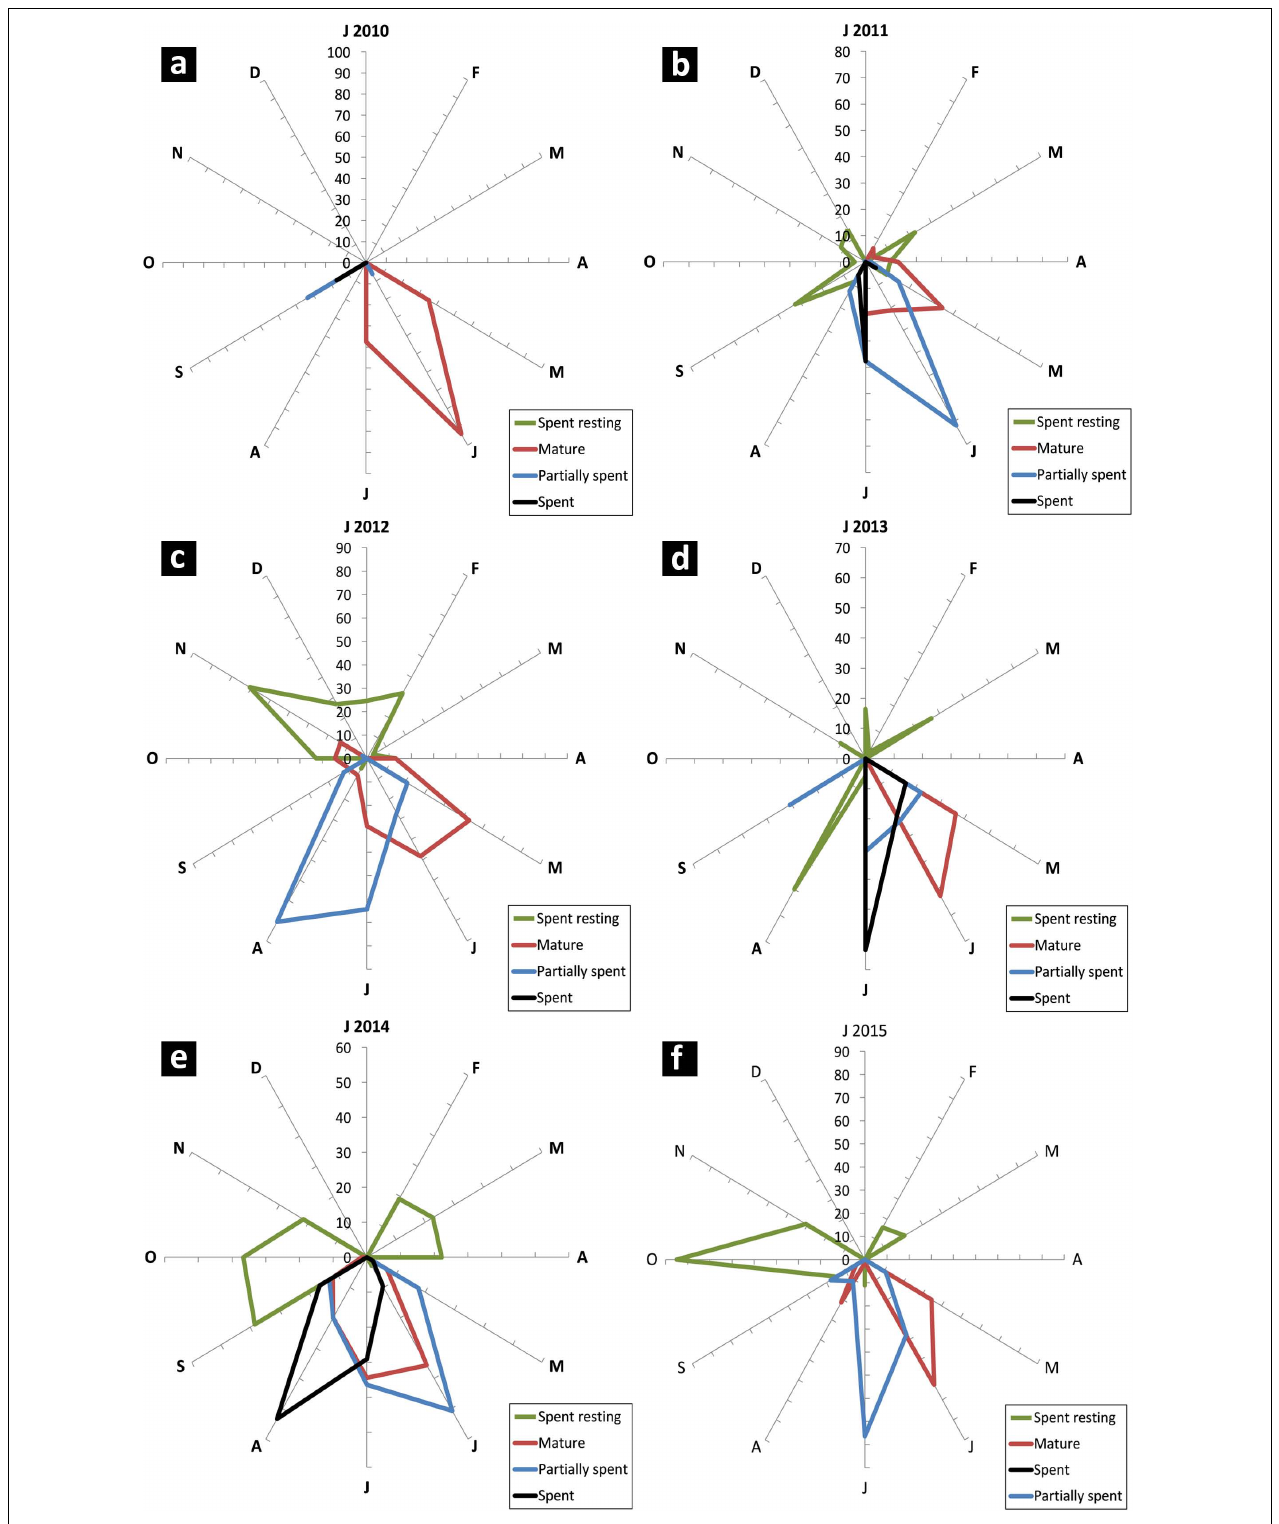
FIGURE 7 | Radar chart of monthly female maturity stages (in percent) of oil sardine from 2010 to 2015 (a–f) . Maturity stages important for indicating peak breeding and spawning are shown. Due to overlap, some stages are not visible.